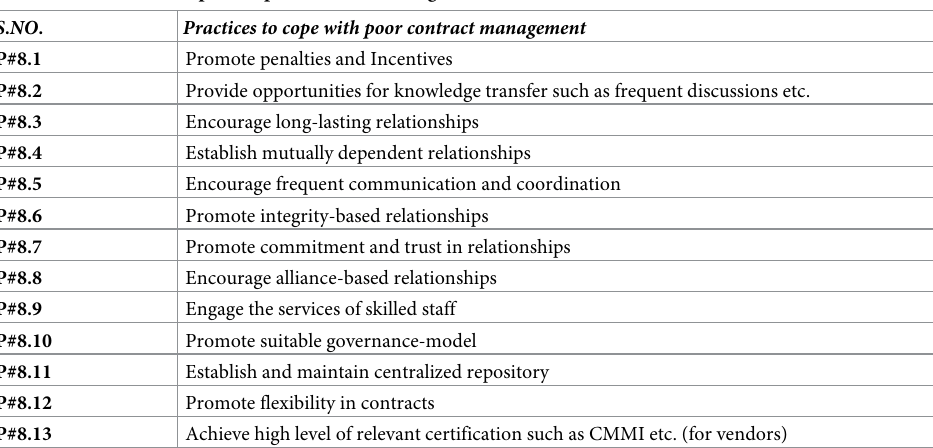
Table 11. Practices to cope with poor contract management in COR.